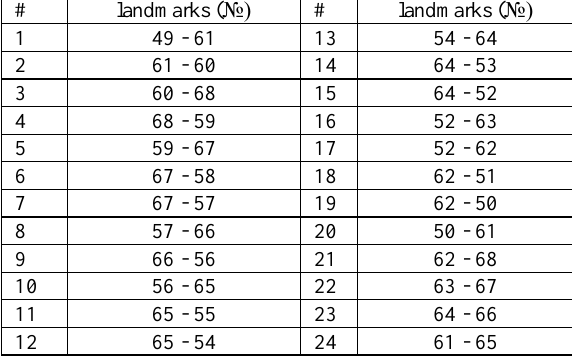
Table 3. Feature extraction